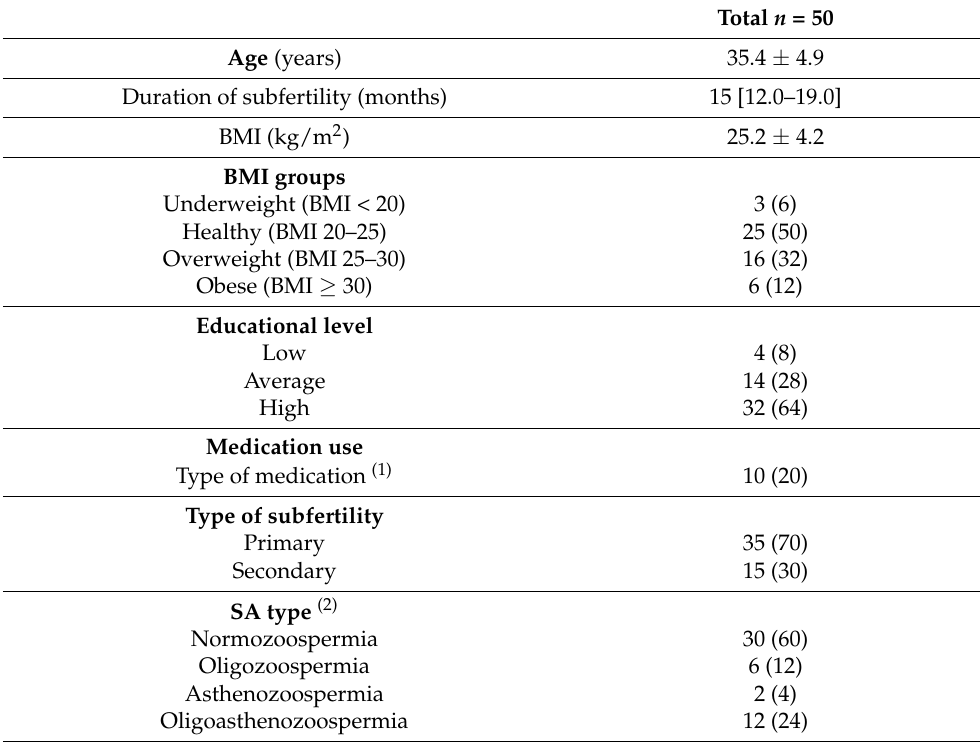
Table 1. Demographic and clinical characteristics of the study